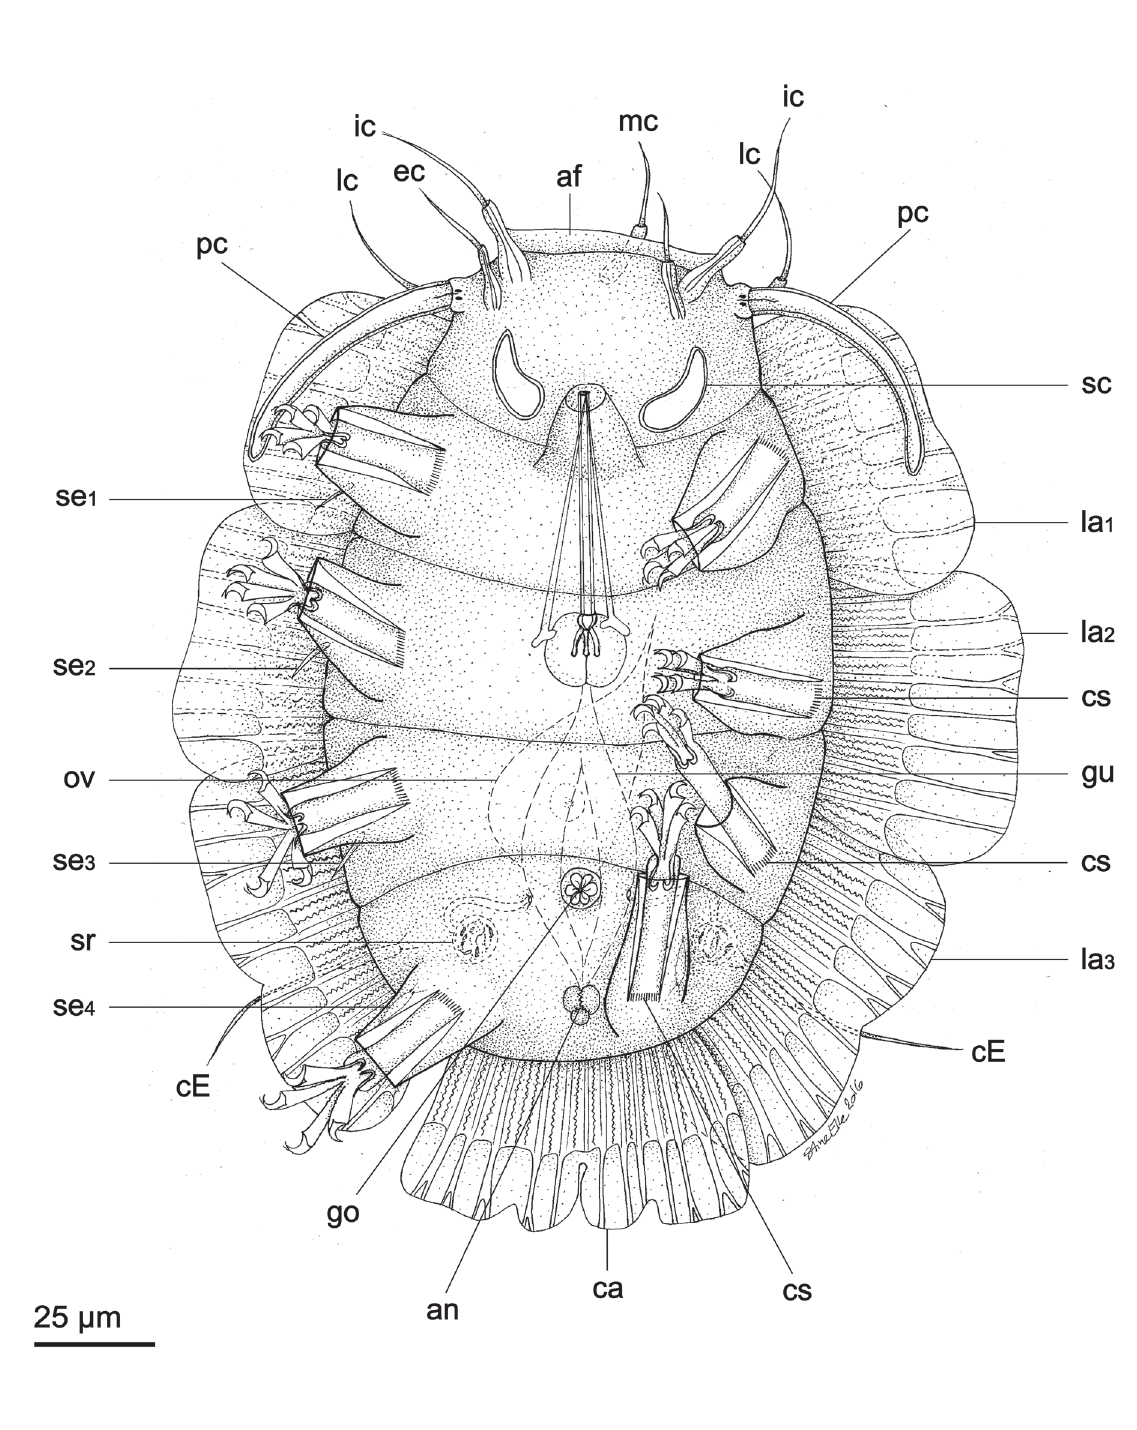
Fig. 8. Higginsarctus shintai gen. et sp. nov., holotype, ♀ (NHMD-293904). Ventral overview. Abbreviations: see Material and methods. Drawing by Stine B.